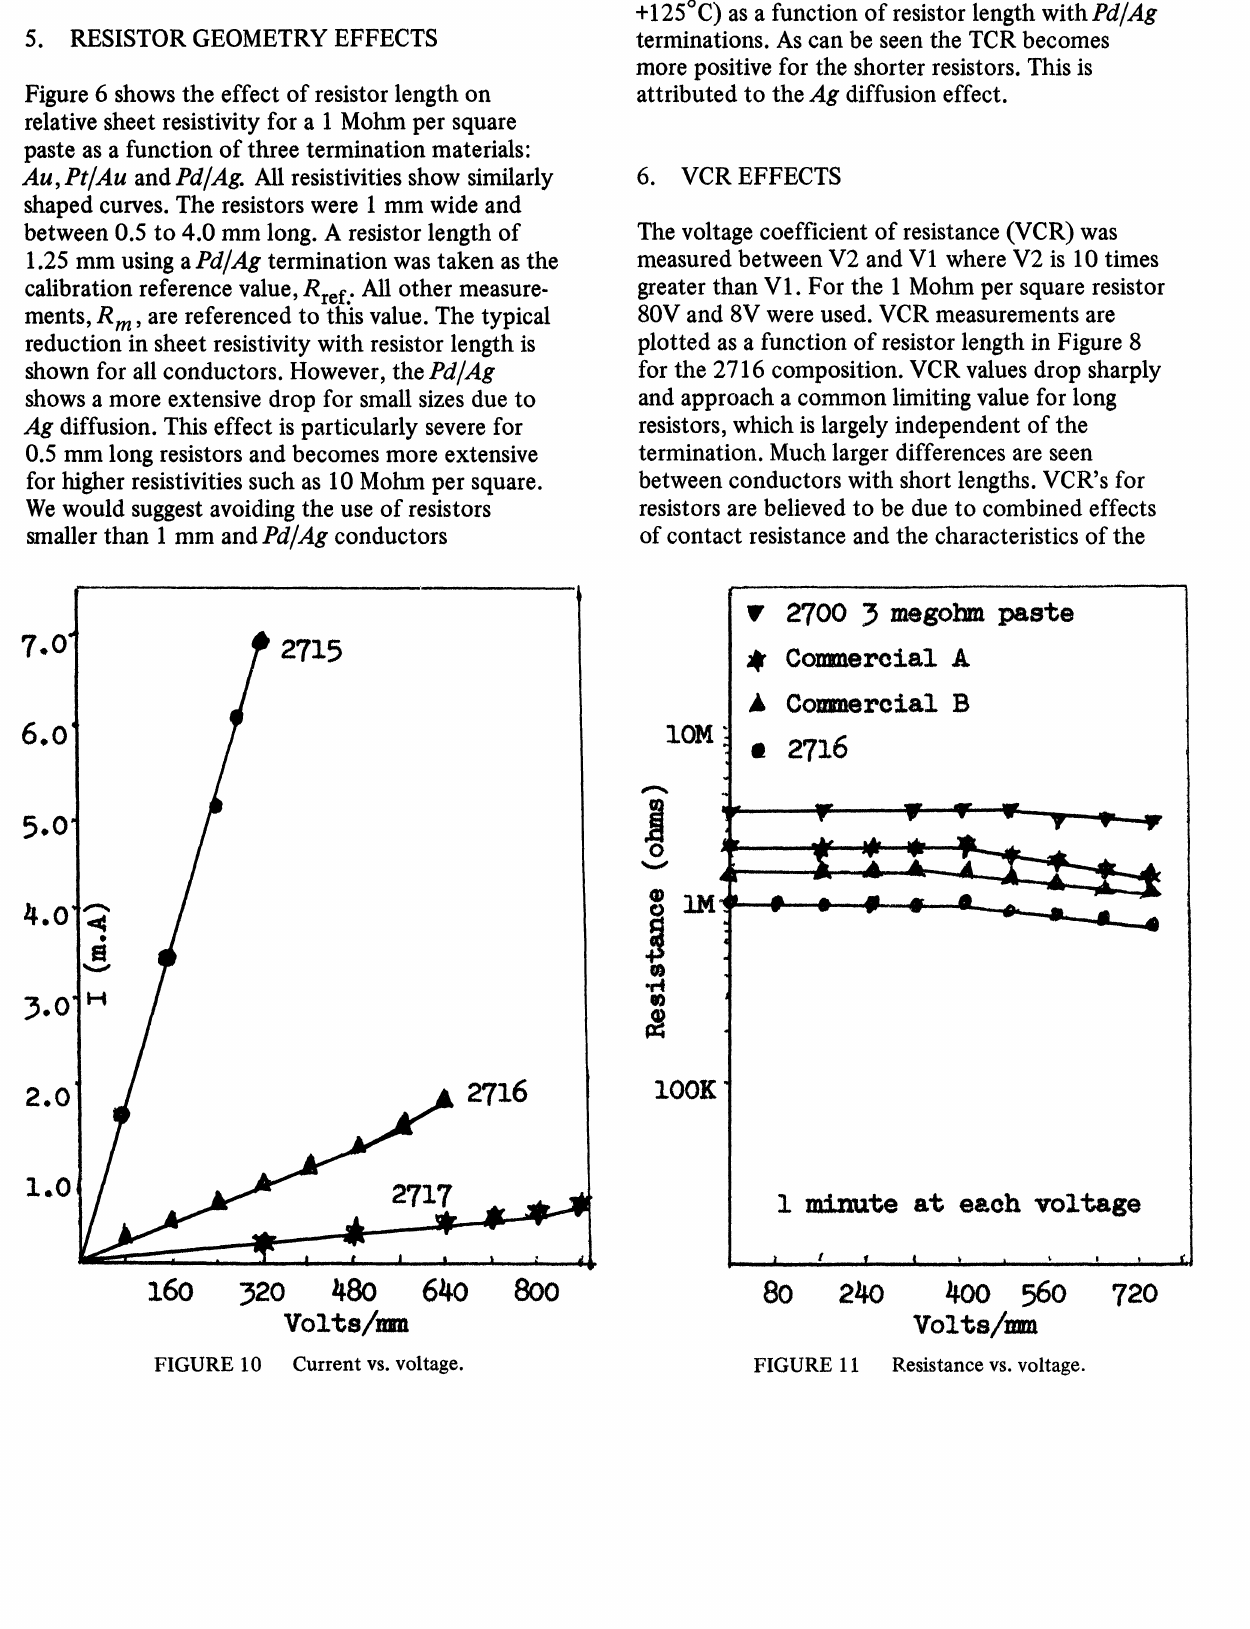
FIGURE 10 Current vs. voltage. FIGURE 11 Resistance vs.